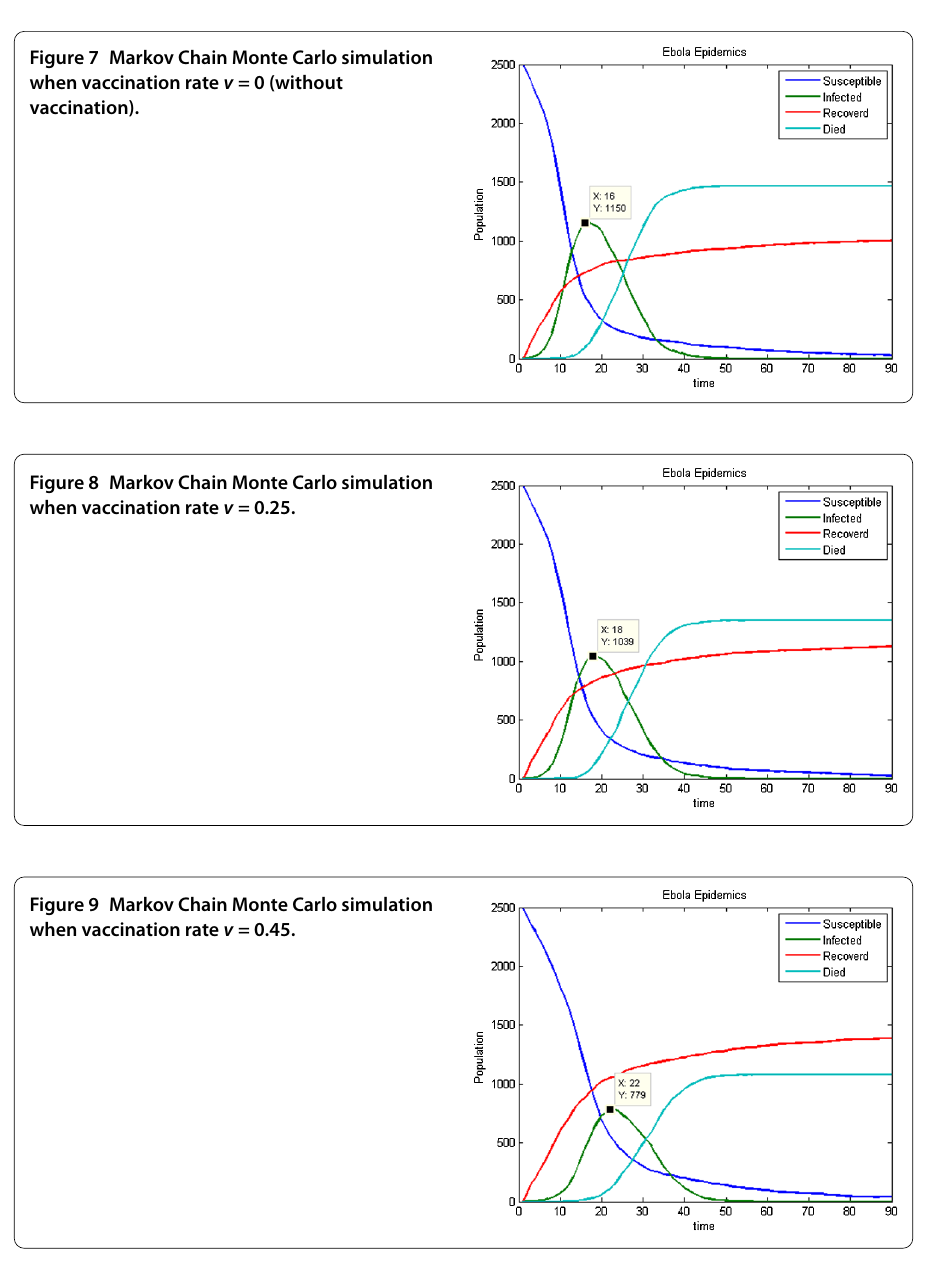
Figure 7 Markov Chain Monte Carlo simulation when vaccination rate v = 0 (without vaccination).